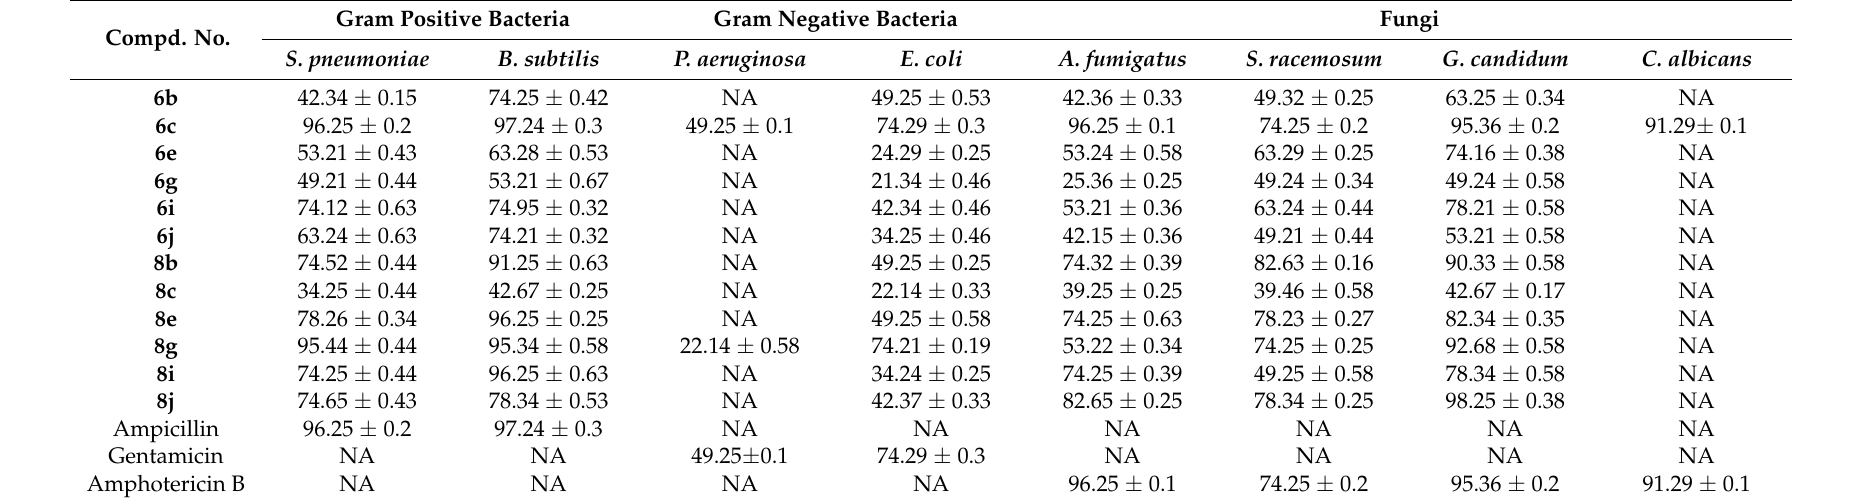
Table 3. Antimicrobial activity of the synthesized compounds.